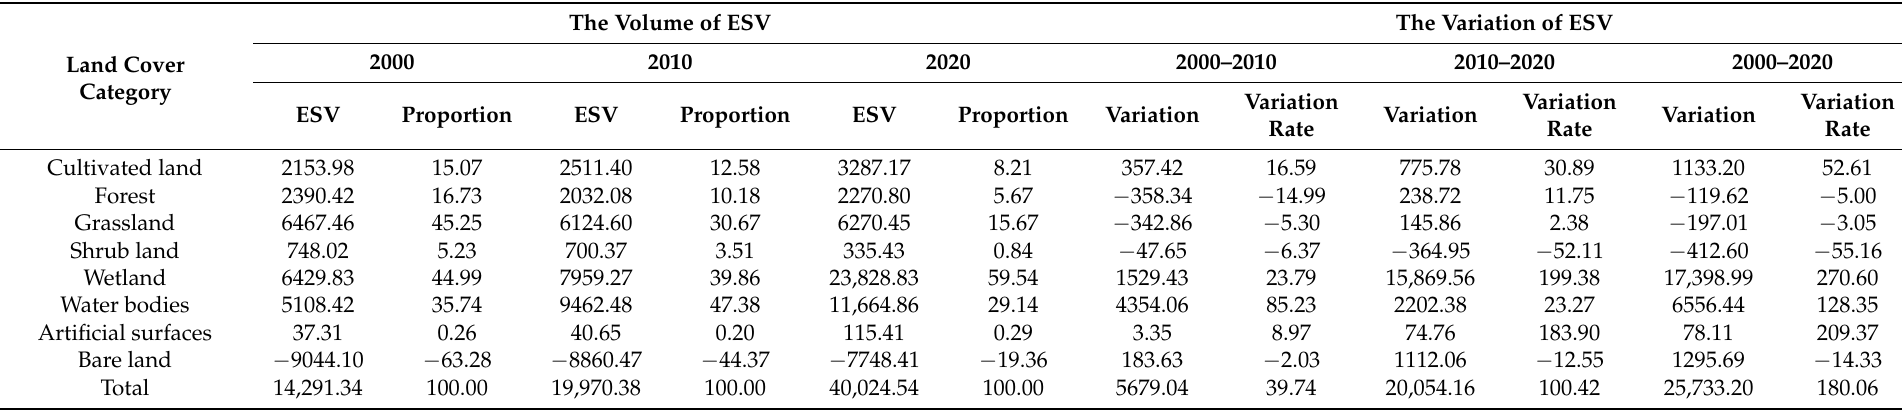
Table 7. The variation in